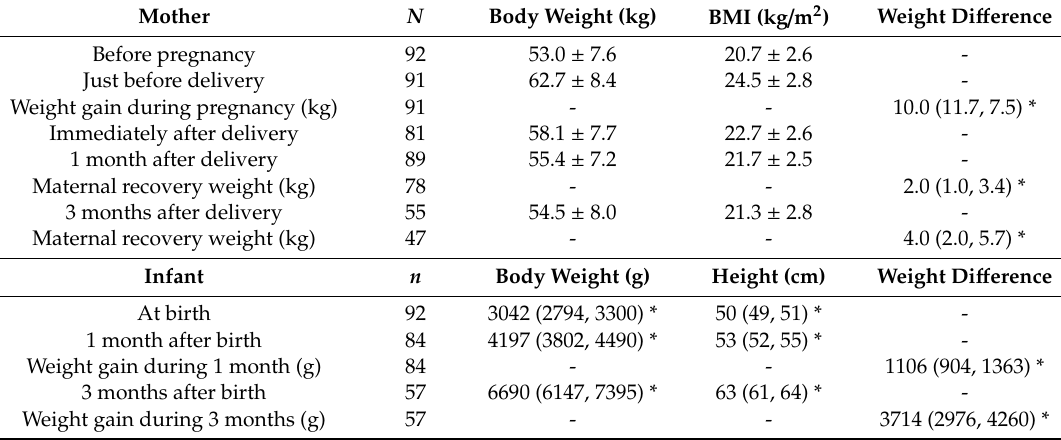
Table 1. Weight of mothers and infants at 1 and 3